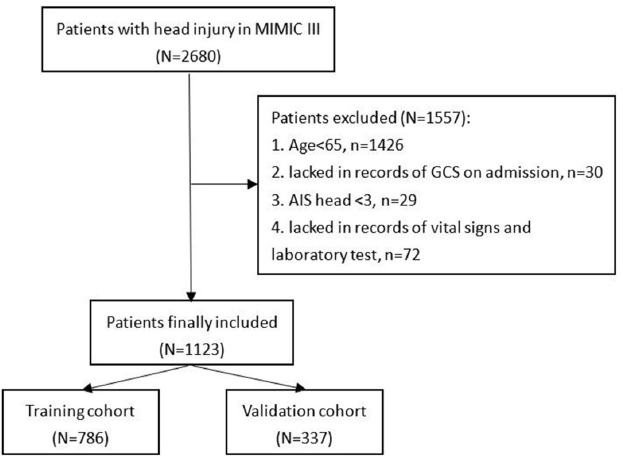
Figure 1. Flowchart of patients’ inclusion.